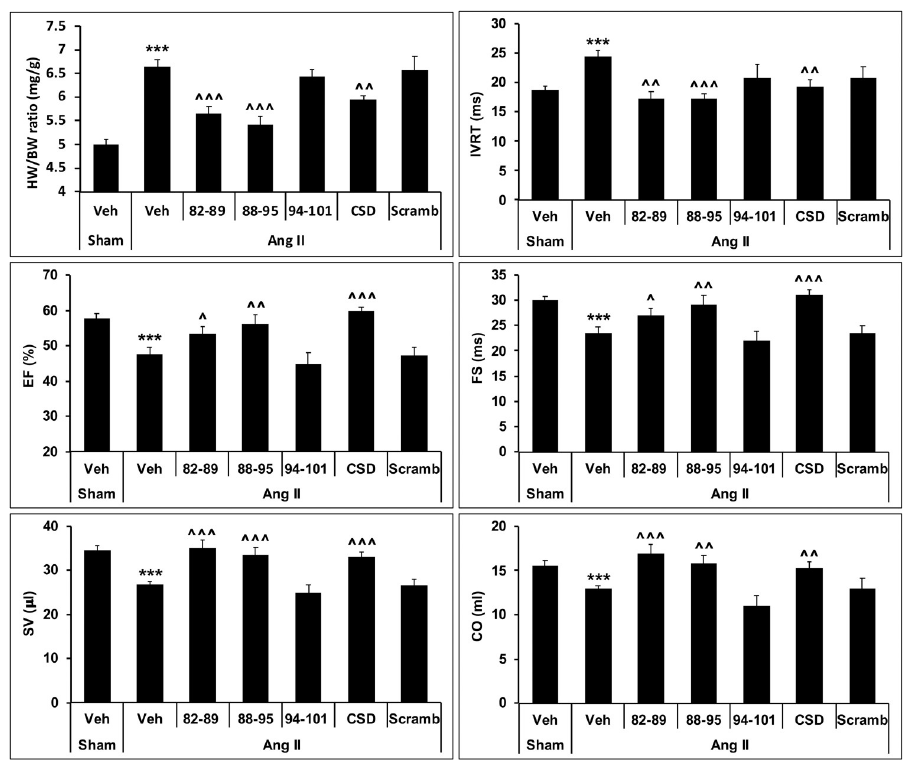
Fig 4. CSD and two subregions suppress Ang II-induced cardiac hypertrophy and pathological changes in ventricular function. Mice were infused for 2 weeks with Ang II (2.1 mg/kg/day) to induce HF or with vehicle. Concomitantly, CSD, scrambled CSD, or subregions were injected daily (i.p., 0.8 μ mol/kg). Cardiac hypertrophy was evaluated in terms of the HW/BW ratio. Cardiac function was evaluated by echocardiography for IVRT, EF, FS, SV, and CO. Significant changes are shown as ��� p < 0.001 vs Sham control. Suppression of AngII-induced changes is shown as ^p < 0.05, ^^p < 0.01, and ^^^p < 0.001 vs AngII control. Additionally, representative images of echocardiography data are provided in the Supplementary